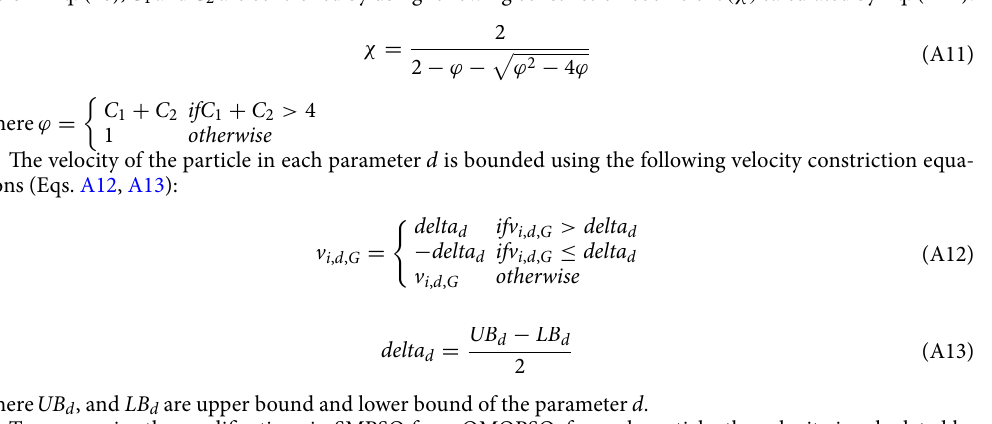
−→ −→ x i , best and x i , G are particle’s best position and −→ L h is a position vector of the selected leader of the h index